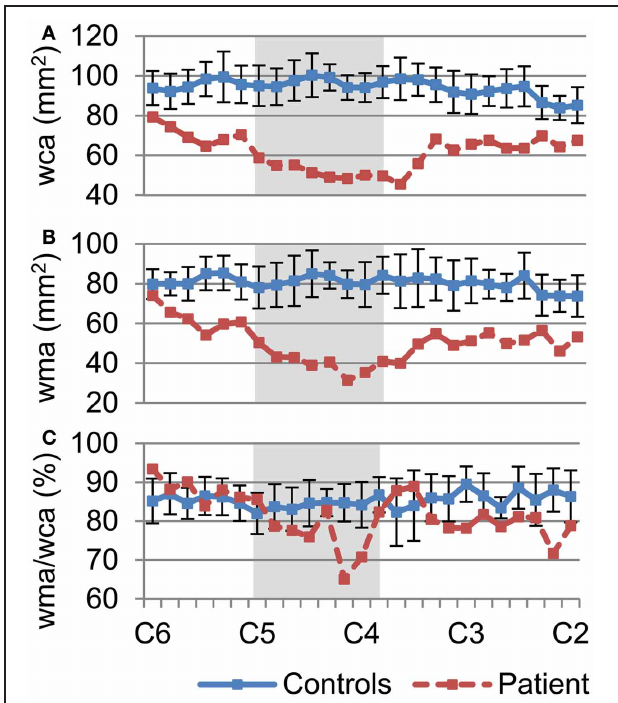
FIGURE 3 | Quantification of whole cord and white matter atrophy, as a measure of white matter tissue sparing throughoutthe cervical spinal cord. (A) Degree of whole cord atrophy, as measured by the whole cord area, (B) white matter area, and (C) the ratio of wma over wca, was measured between C2–C6. Values of the controls (blue line) are mean ± SD. Plot of wca (A) and wma (B) demonstrate atrophy of the patient’s spinal cord not only at the injury epicenter (dark area) but throughout the cervical cord. Plot of ratio of wma over wca (C) shows marked decrease of white matter around the injury